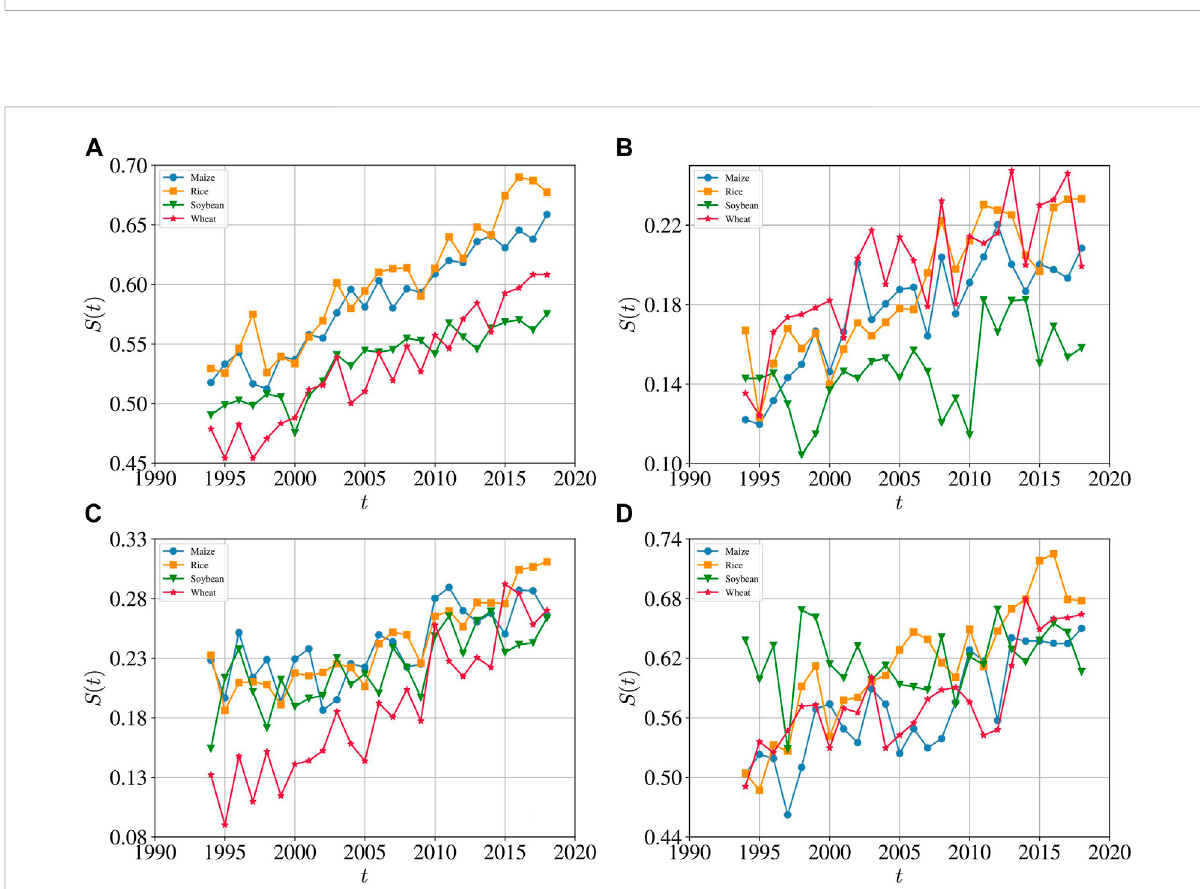
FIGURE 5 Evolution of the temporal similarity coef fi cient S ( t ) between two successive networks of the four crops from 1993 to 2018. (A) All links at each time. (B) Light links with the weights at each time less than the 20% percentile. (C) Medium links with the weights at each time between the 40 and 60%percentiles. (D) Heavylinkswiththeweightsateachtimegreaterthanthe80%percentile.Thetemporalsimilarityincreasedovertimewithslight fl